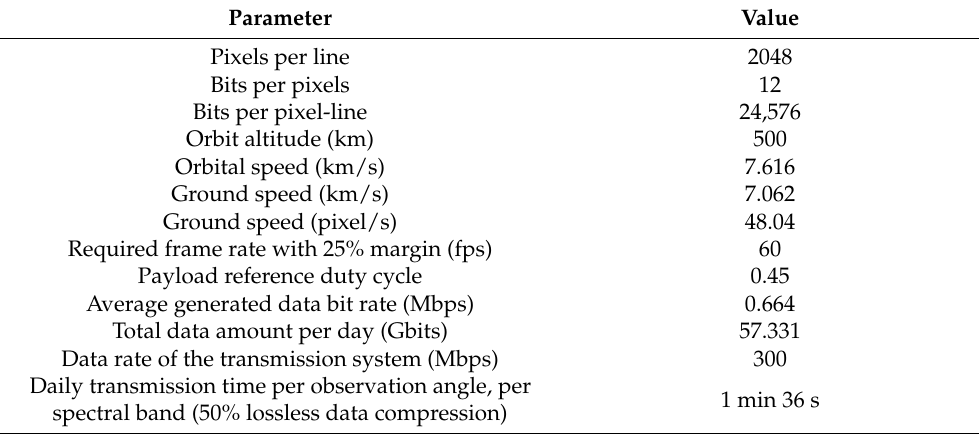
Table 13. Data amount generated in one single acquisition in one observation angle.